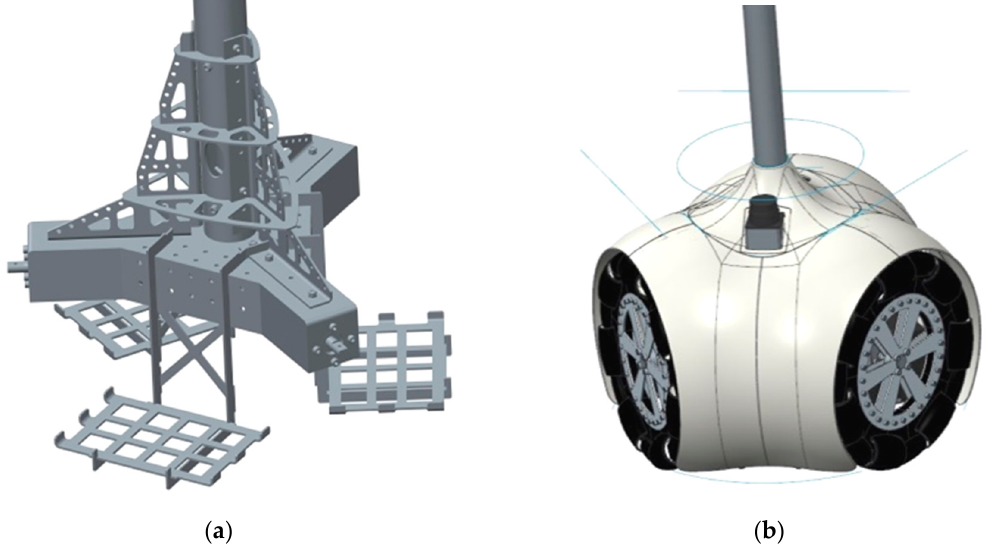
Figure 2. CAD design of the base of the APR: ( a ) mechanical structure and ( b ) plastic cover.